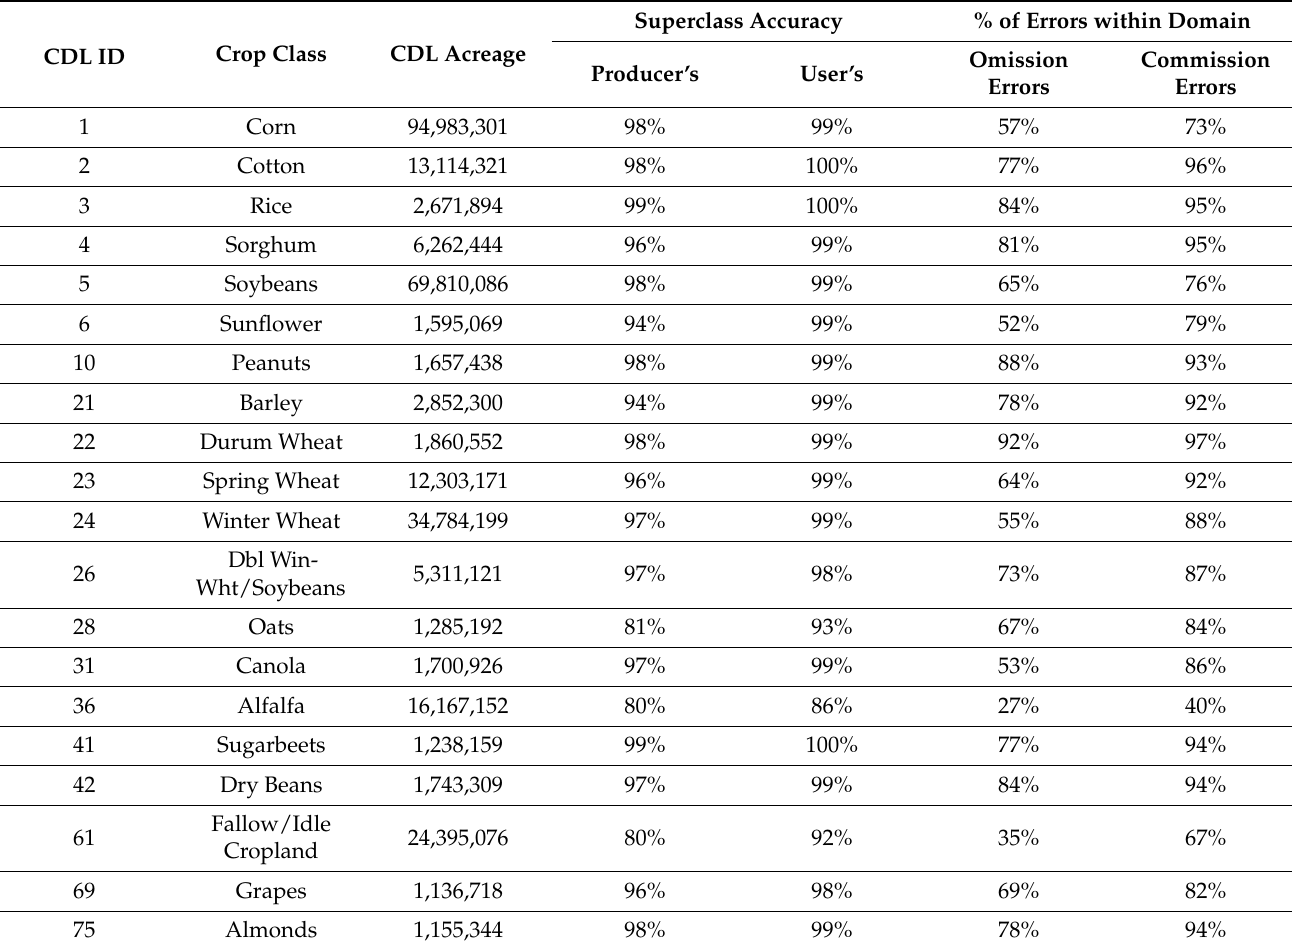
Table 4. Superclass producer and user accuracies for the top 20 classes by area in the cropland domain in 2012 as well as the relative rate of within-domain errors. Superclass accuracy is the likelihood that a given crop is identified correctly as cropland. Percentage of errors within domain is the proportion of errors in the original CDL where the confusion occurs among two crops within the cropland domain, rather than between a crop and non-cropland